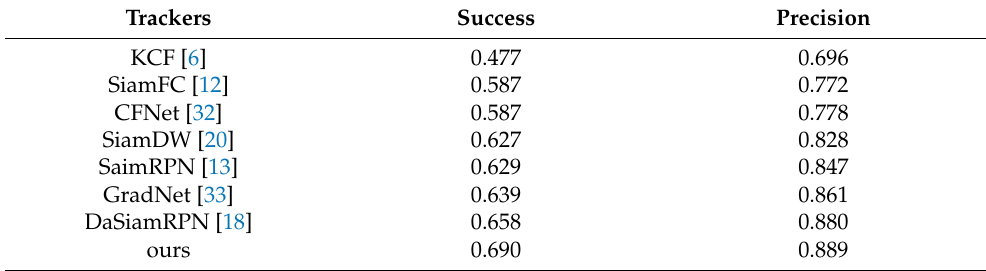
Table 1. Evaluation results on